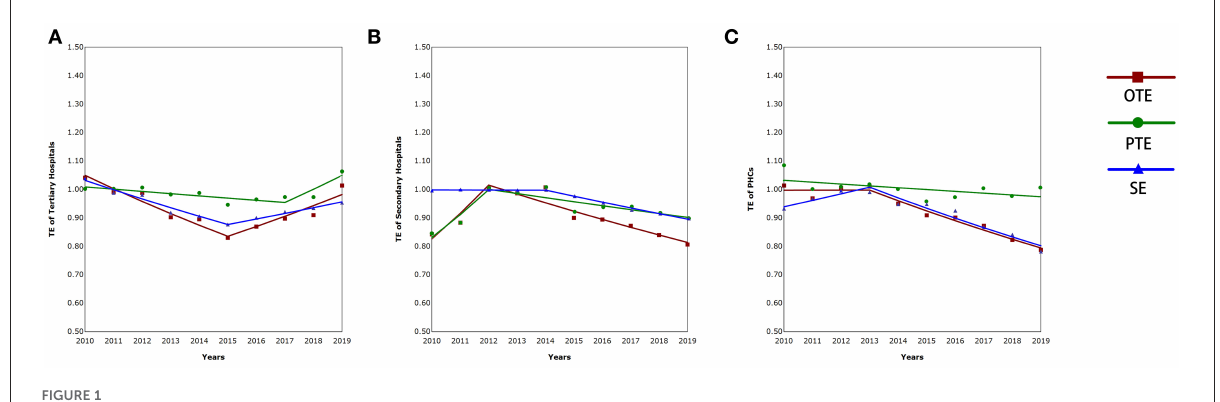
FIGURE1 The technical efficiency of tertiary hospitals (A) , secondary hospitals (B) , and PHCs (C) .